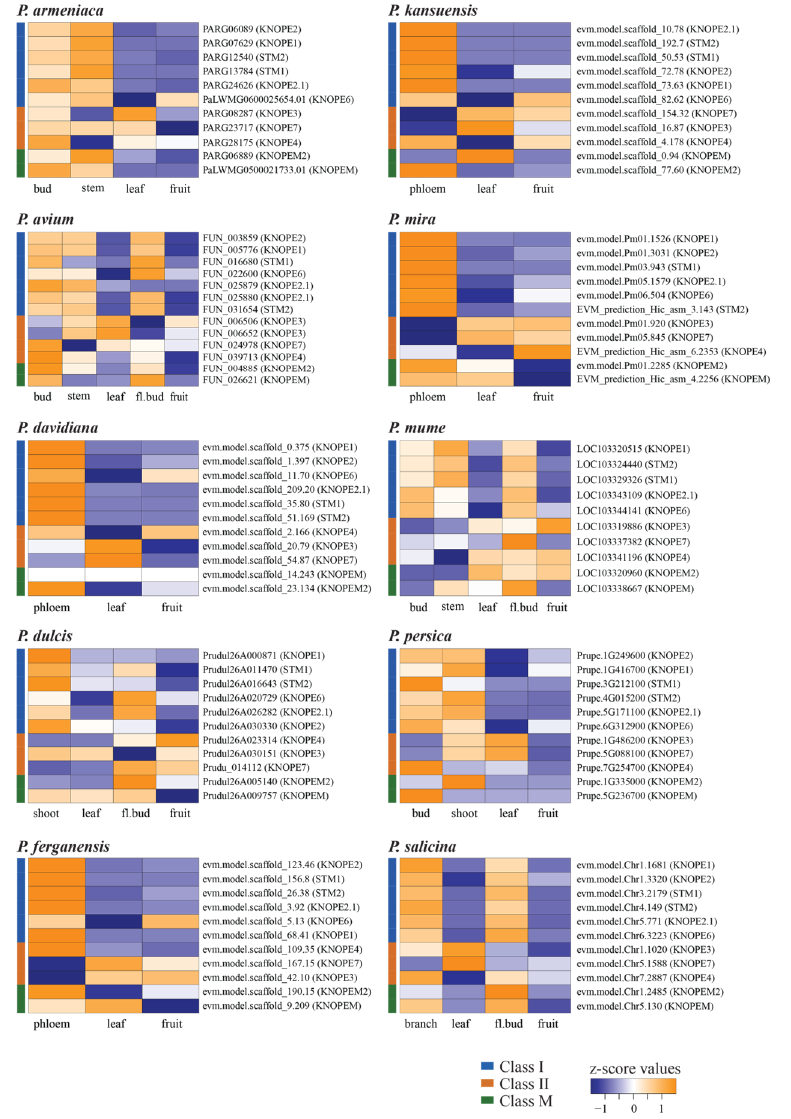
Figure 5. Prunus genome-wide transcription analysis of PRUNOX genes active in aerial organs. The expression profiles refer to 10 species through heat maps of the z-scores, where orange and blue indicate higher and lower expression, respectively. fl., flower.